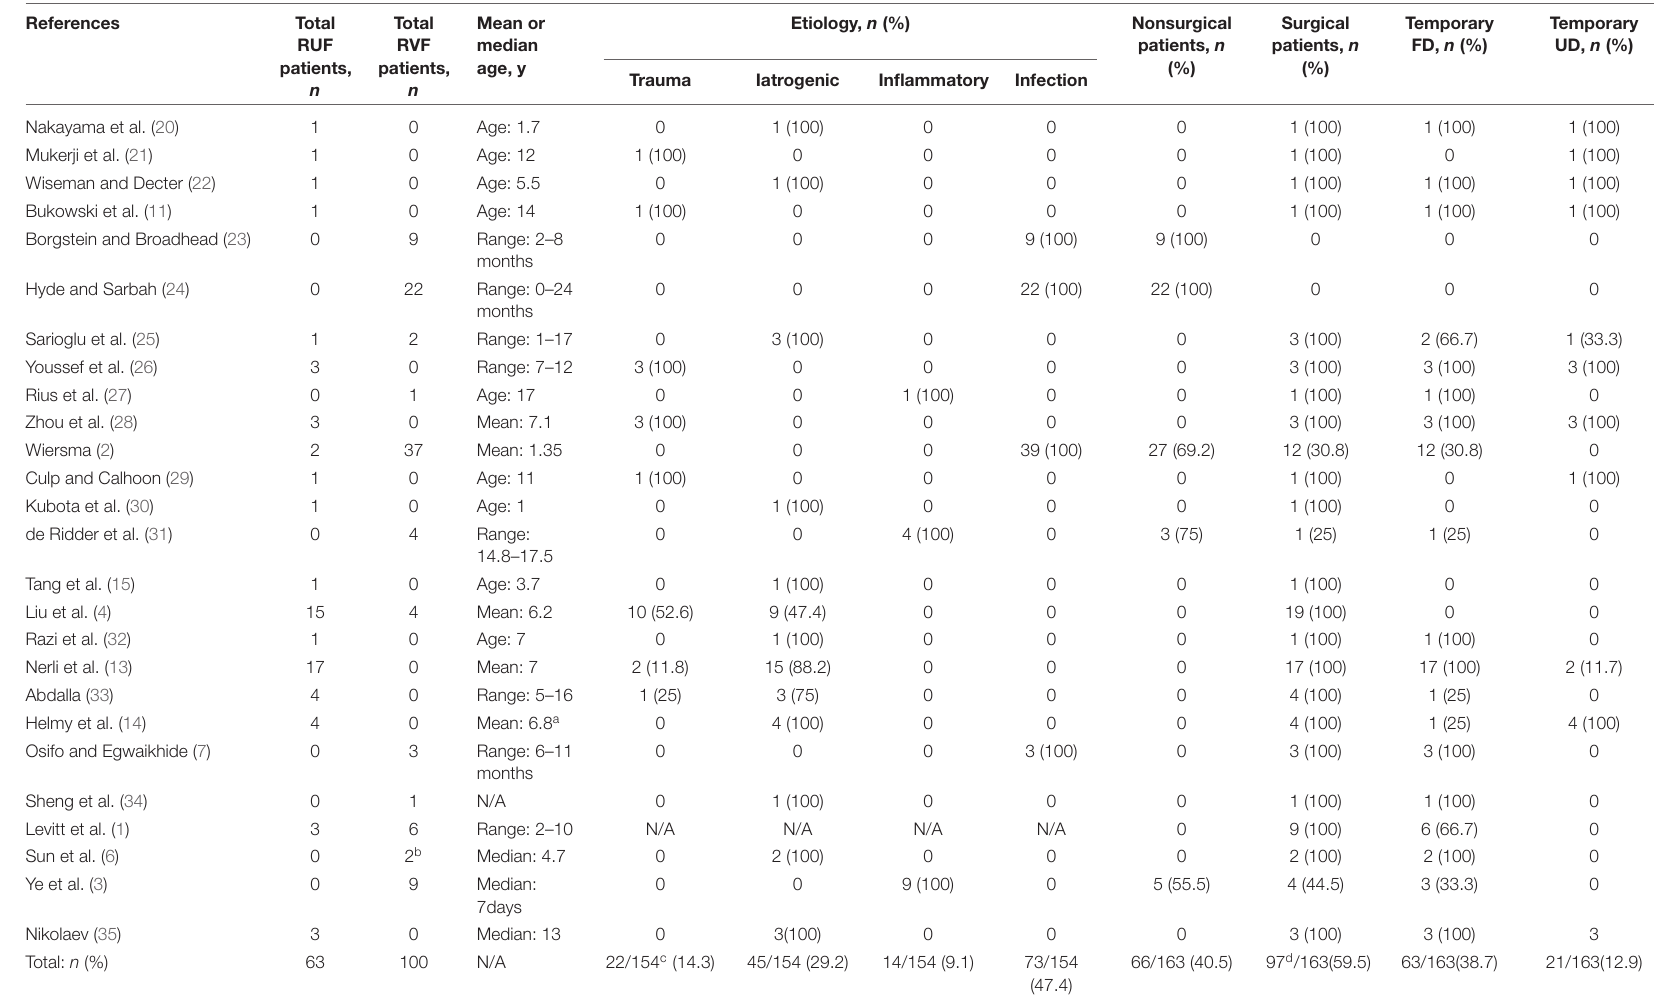
TABLE 1 | Summary statistics for overall patient-specific data across all 26 selected